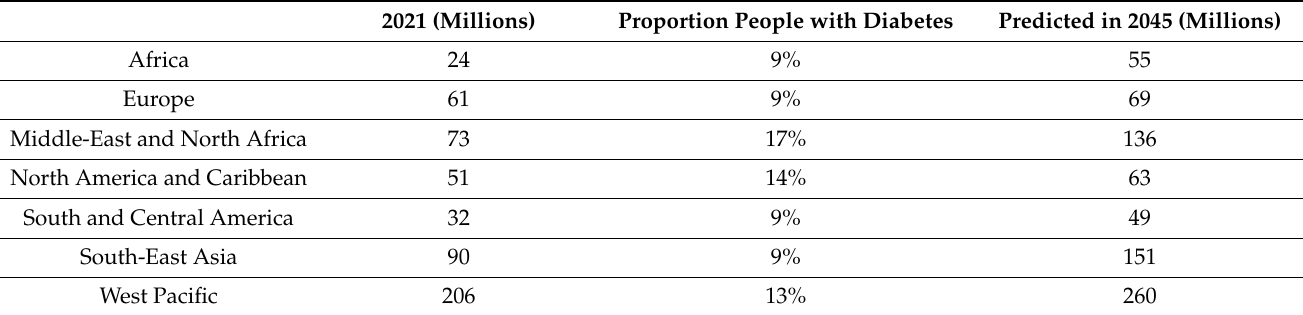
Table 1. Number of adults (20–79 y) in 2021 and 2045 with diabetes around the world. 2021 (Millions) Proportion People with Diabetes Predicted in 2045 (Millions) 24 9%